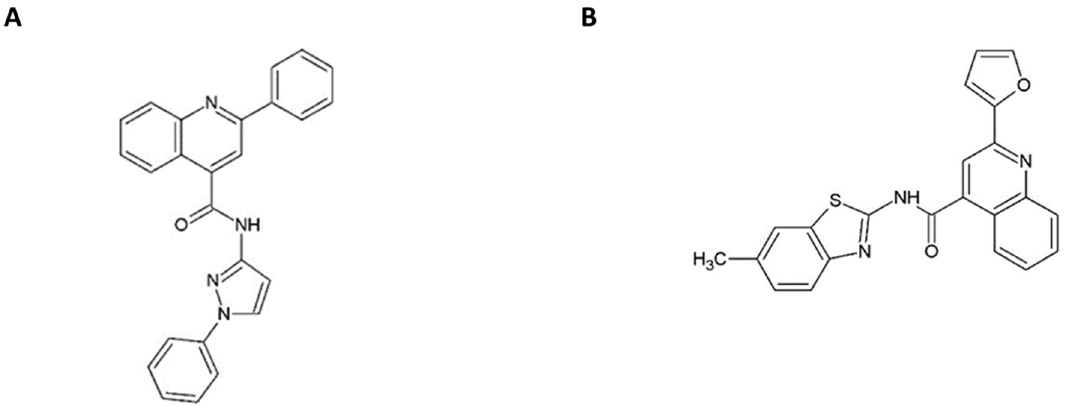
Figure 1. Structural formula of the quinolinecarboxamide A TO502-2403 (CSFCII) B TO505-6180 (CSFCI).